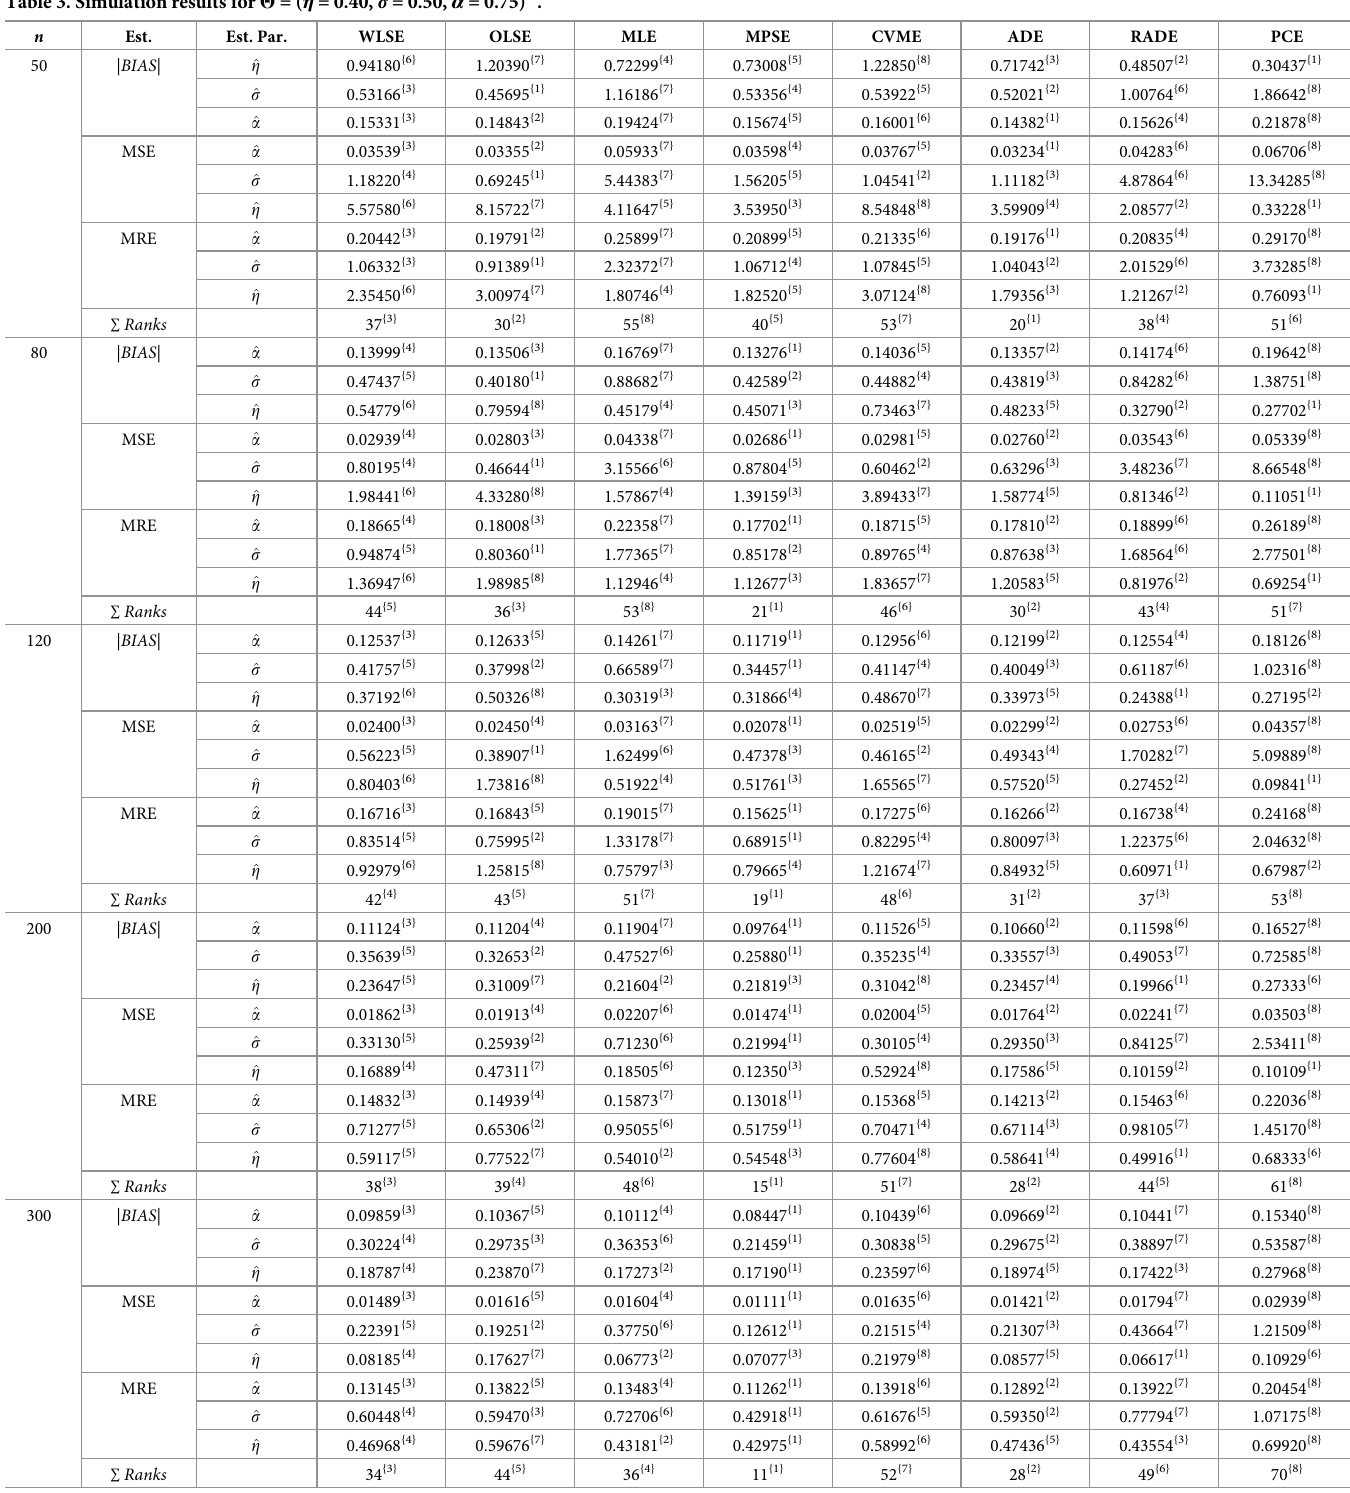
Table 3. Simulation results for Θ = ( η = 0.40, σ = 0.50, α = 0.75) > . n Est. Est.